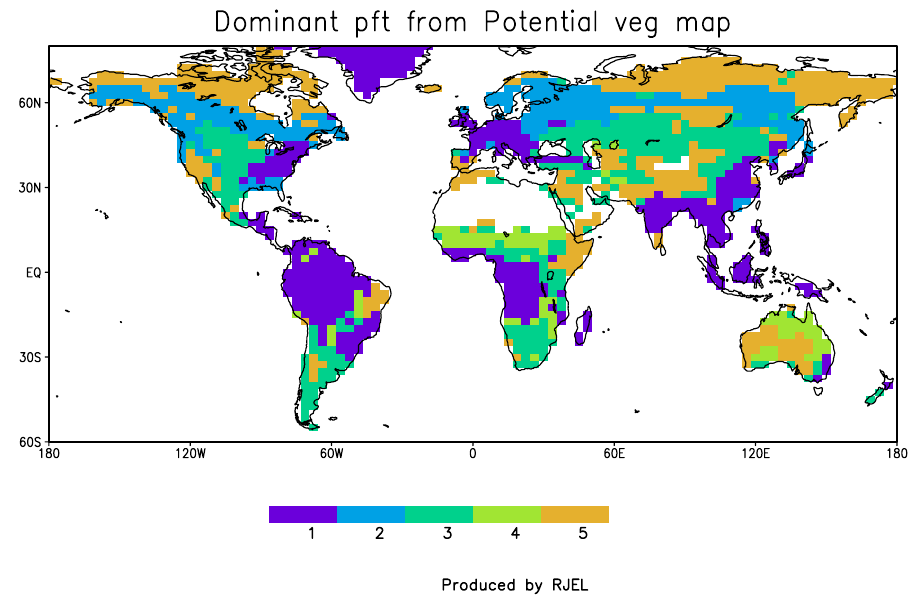
Fig. 1b. Potential vegetation